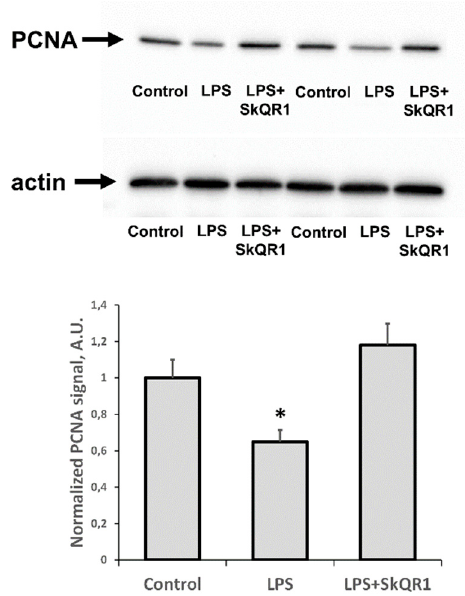
Figure 5. Proliferative activity of kidney cells of neonates 24 h after LPS treatment. Immunoblots for proliferating cell nuclear antigen (PCNA) levels in neonatal kidneys and their densitometry analysis in the diagram, respectively. The SkQR1 treatment restored the levels of PCNA to intact kidney values. Actin was used as a loading control. Number of animals for western blot was n = 4. *: p < 0.05, compared to control.